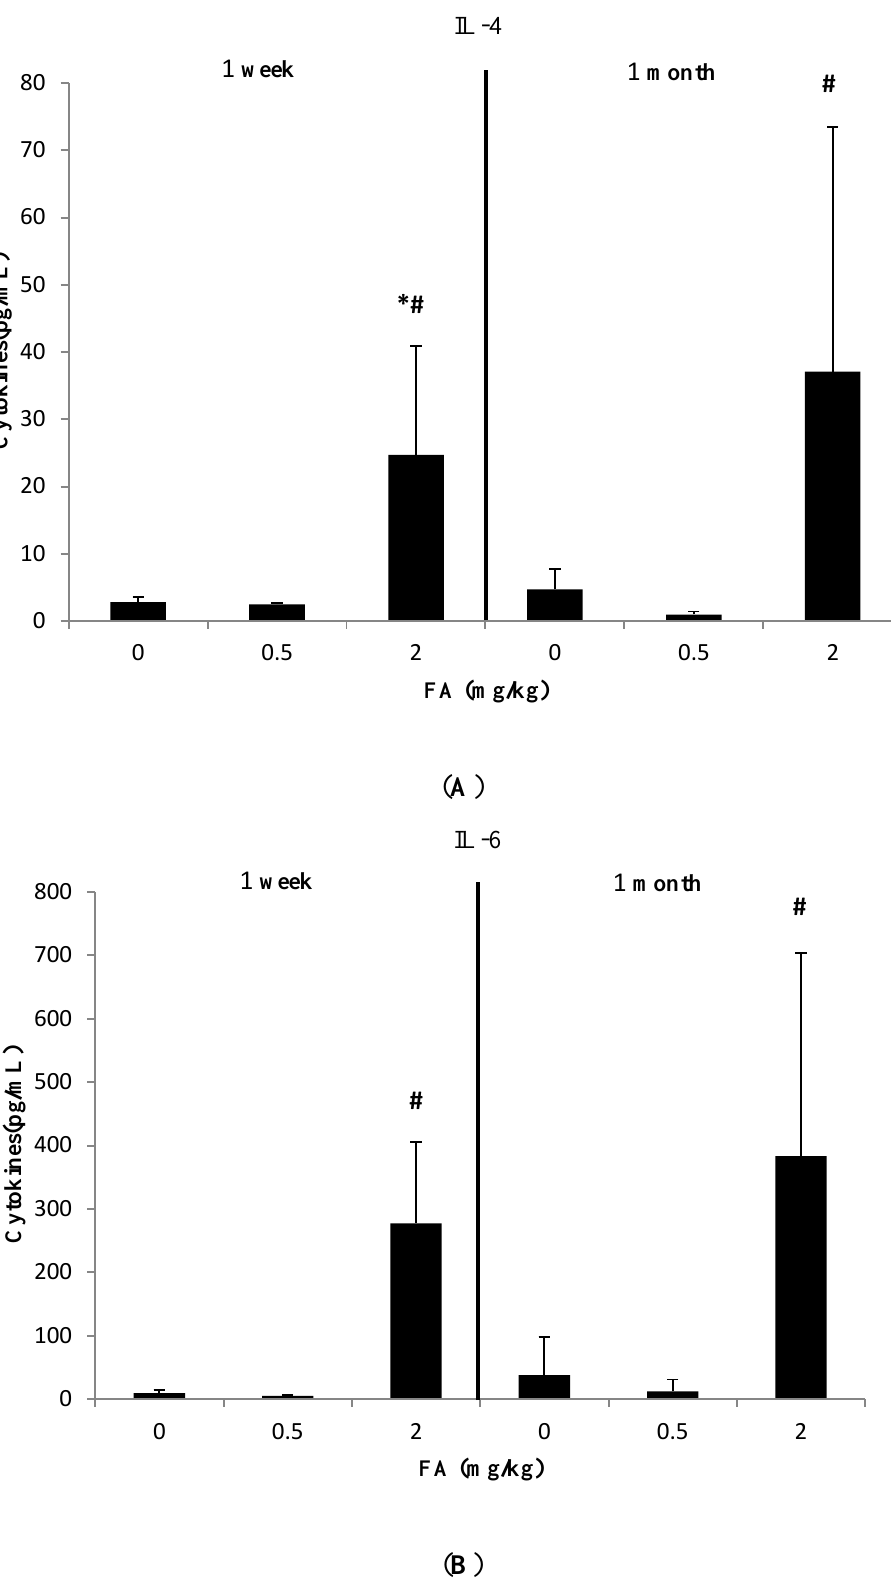
Figure 2. Effects of FA on IL-4, IL-6, and IL-10 (Th2-related cytokines) in serum of C57BL/6 mice. ( A ) Effect of FA on IL-4 in serum of C57BL/6 mice; ( B ) Effect of FA on IL-6 in serum of C57BL/6 mice ( C ) Effect of FA on IL-10 in serum of C57BL/6